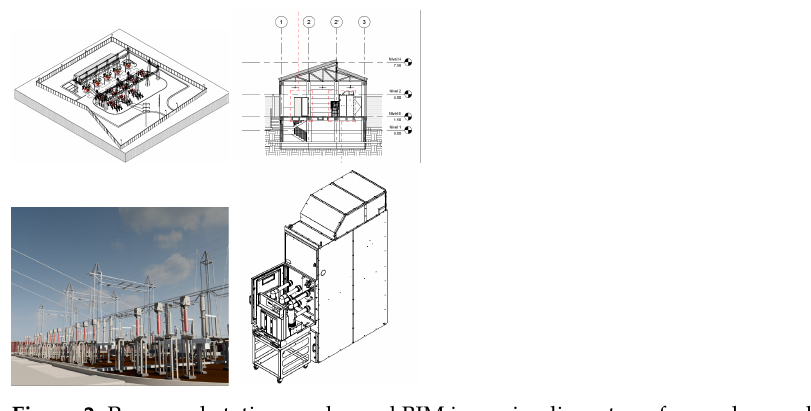
Figure 2. Power substation render and BIM incoming lines, transformer bay and switch gears with LOD